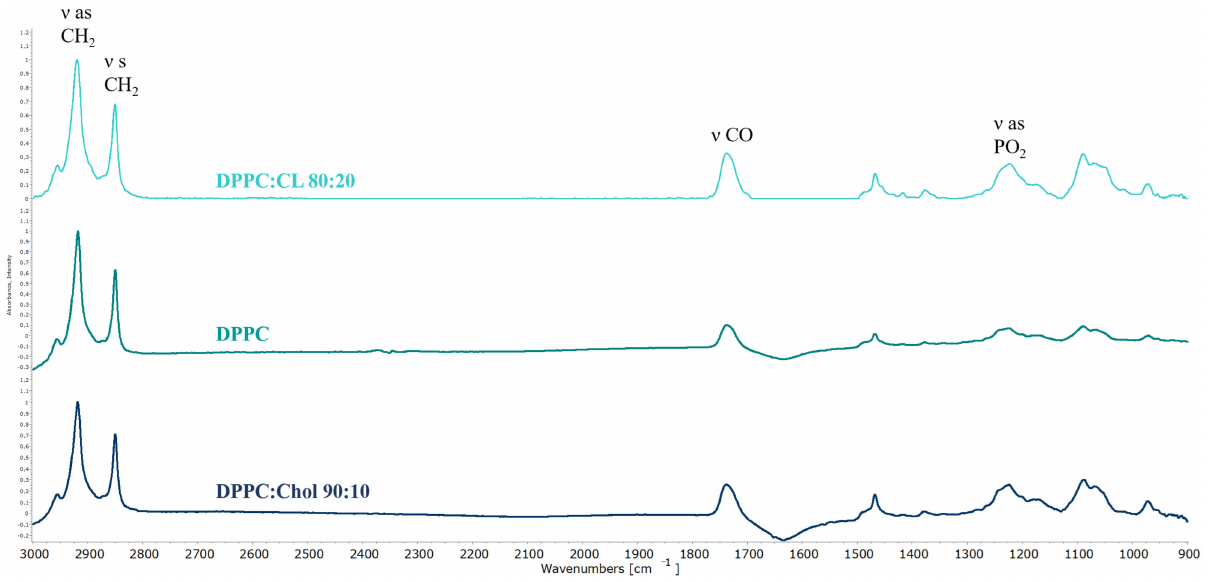
Figure 2. Normalized ATR-FTIR spectra of liposomes of various lipid composition: DPPC:CL 80:20, DPPC, DPPC:Chol 90:10. Total lipid concentration 5 mg/mL. 0.02 M Na phosphate-buffered solution, pH 7.4, 22 ◦